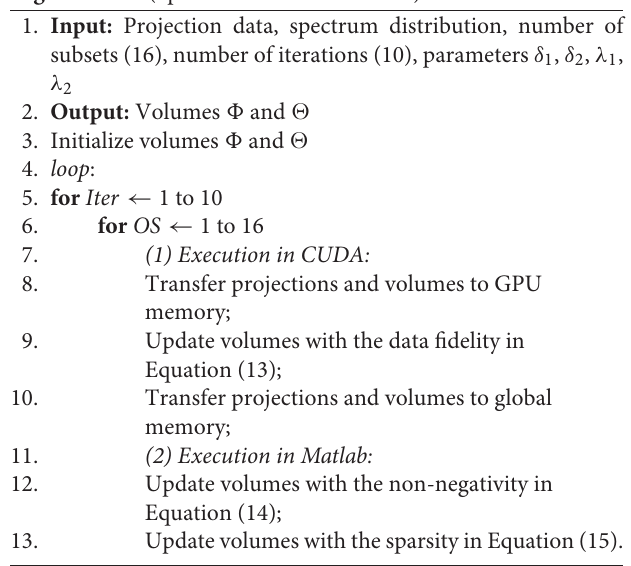
Algorithm 1 : (Spectral CT reconstruction)